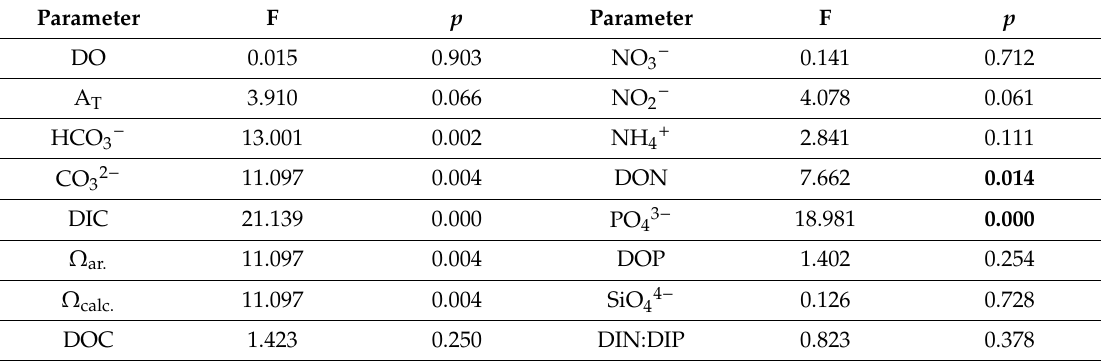
Table 2. One way ANOVA results (F, p ) for all experiment parameters regarding seawater analyses ( p values < 0.05 are marked in bold, which indicate statistical significance between the two treatments).